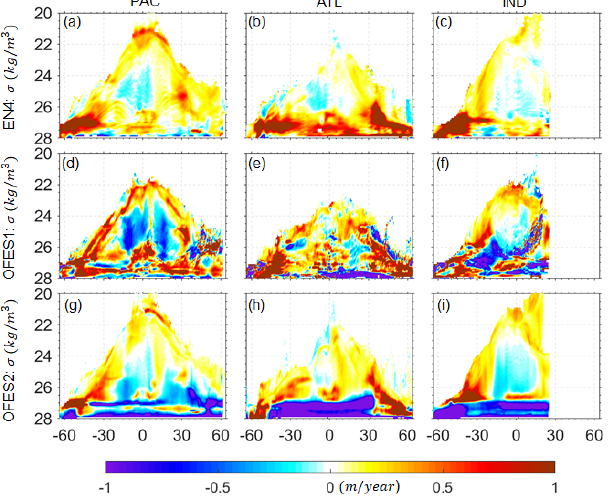
Figure 17. Linear trends in the zonal-averaged sinking of the neu- tral density surfaces in the Pacific (a, d, g) , Atlantic (b, e, h) , and Indian (c, f, i) oceans. Top to bottom: EN4, OFES1, OFES2. Pos- itive values mean deepening of the neutral density surfaces. The calculation was for the water above